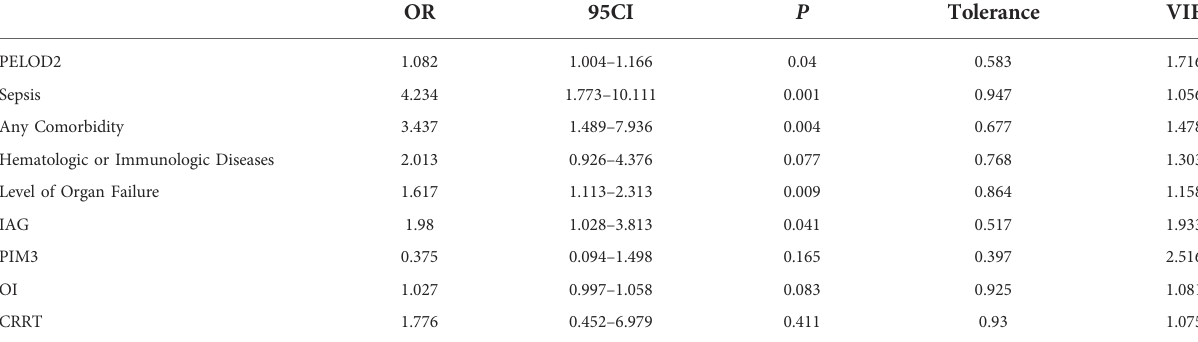
TABLE 4 Multivariate logistic regression models.